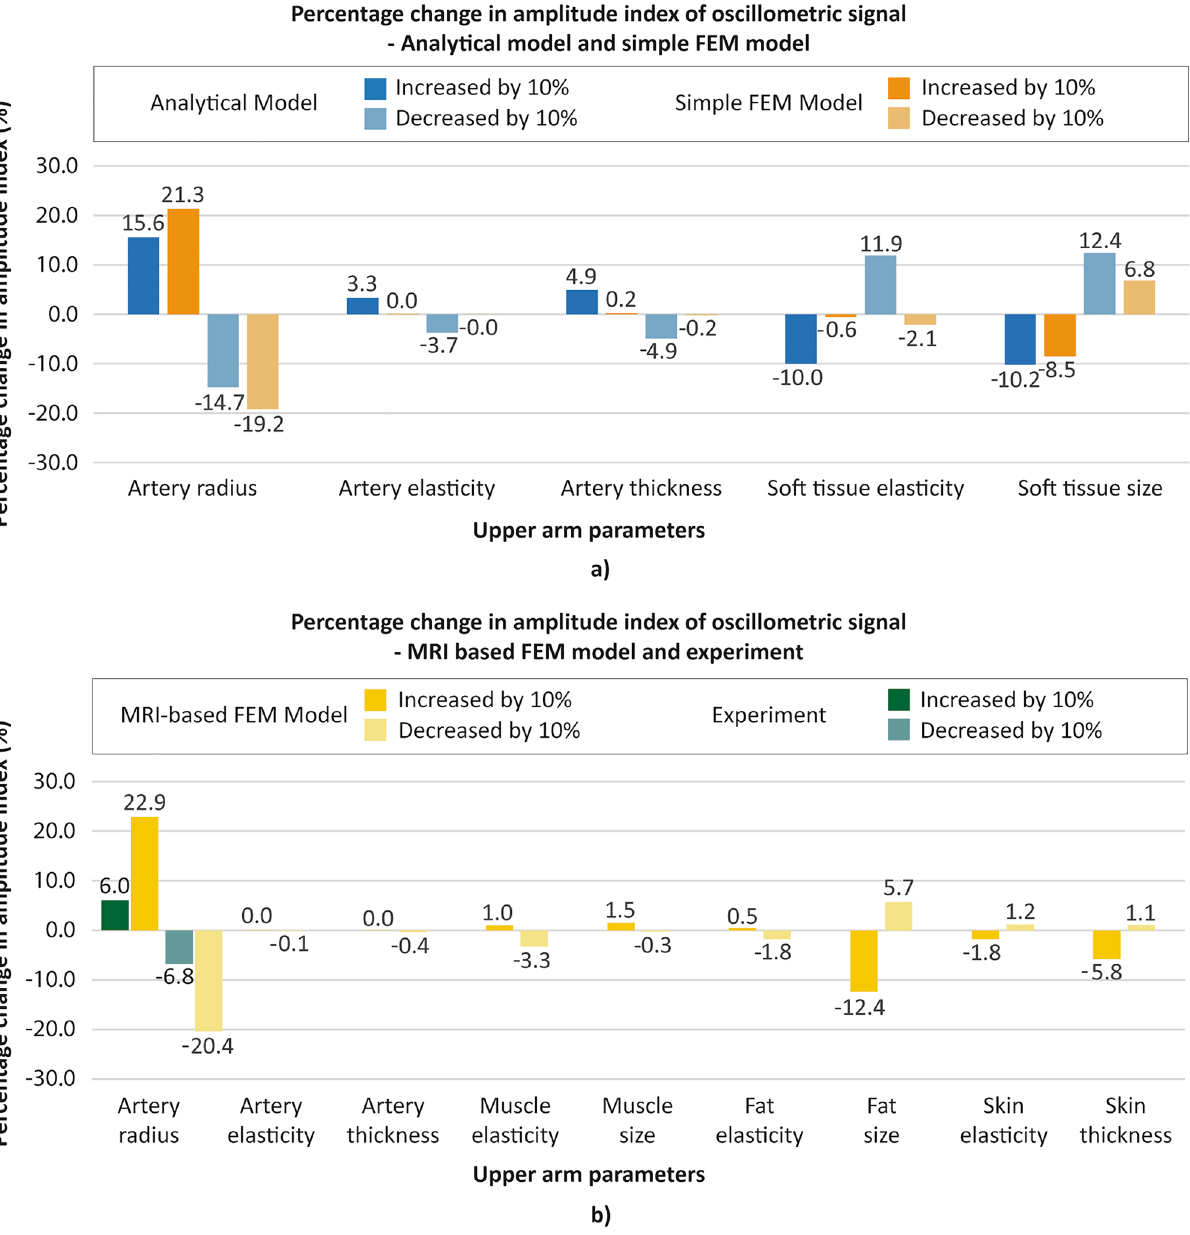
Figure 6. Parametric study results. The percentage change in amplitude index of oscillometric signal when upper arm parameters are varied for each model. ( a ) Parametric study results with analytical model and simple FEM model, ( b ) Parametric study results with MRI-based FEM model and